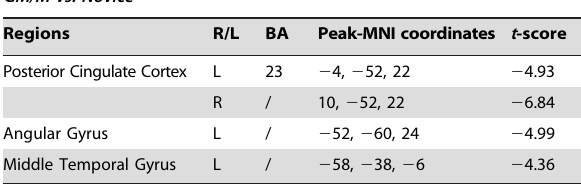
Table 2. Deactivation differences in the DMN during Chinese chess problem-solving task (Game condition vs. Blank condition) (Two sample t -test, p , 0.05, AlphaSim